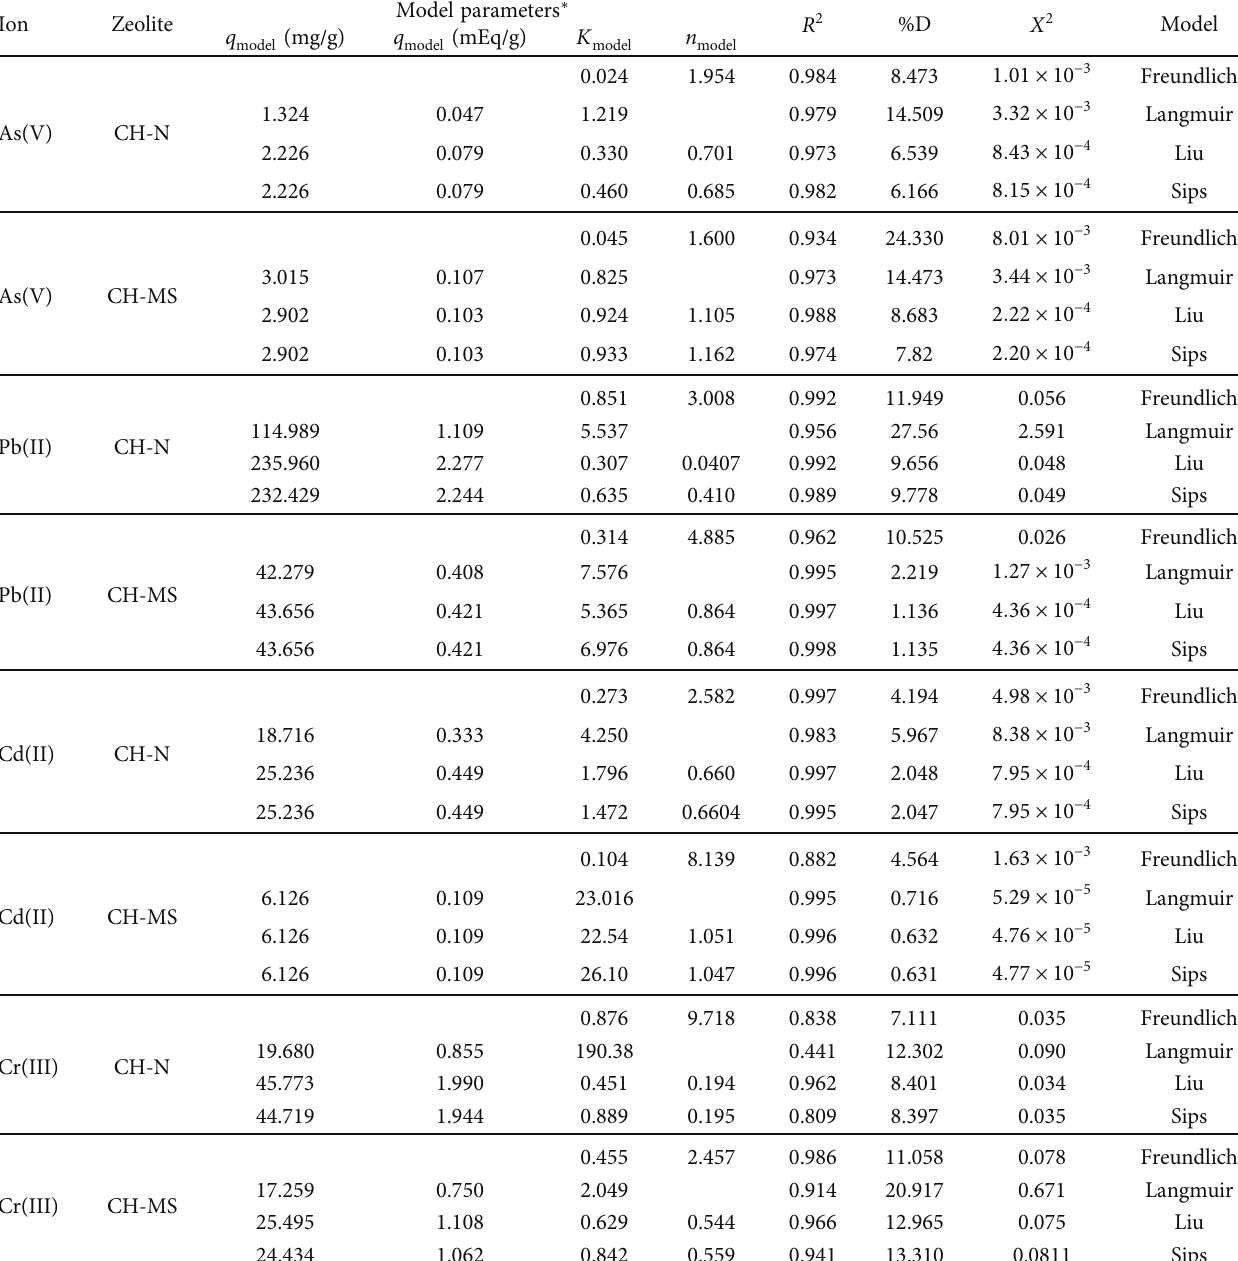
Table 3: Results of isotherm fi tting using the Langmuir, Freundlich, Sips, and Liu equations for the adsorption of As(V), Pb(II), Cd(II), and Cr(III) on CH-N and CH-MS